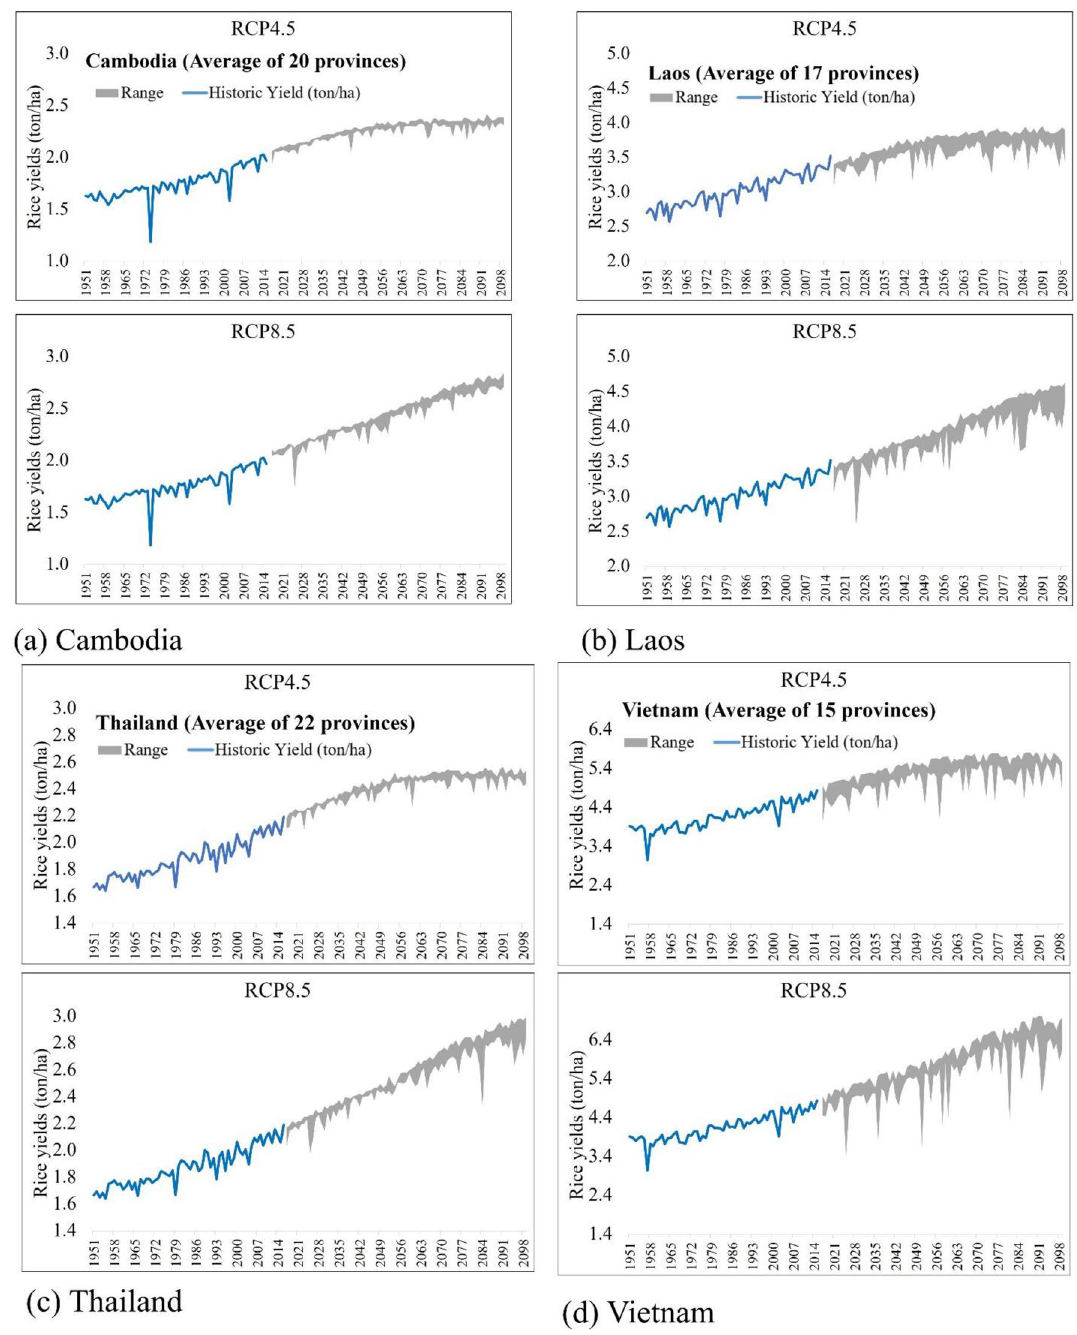
Figure 5. Time series of simulated rice yields for ( a ) Cambodia, ( b ) Lao PDR, ( c ) Thailand, and ( d ) Vietnam. X-axis represents the historical and future periods (1951–2099), and Y-axis indicates the rice yields (ton/ha). Blue lines present the average simulated rice yields for the historical period, and gray areas present the range of the simulated rice yields from the four climate